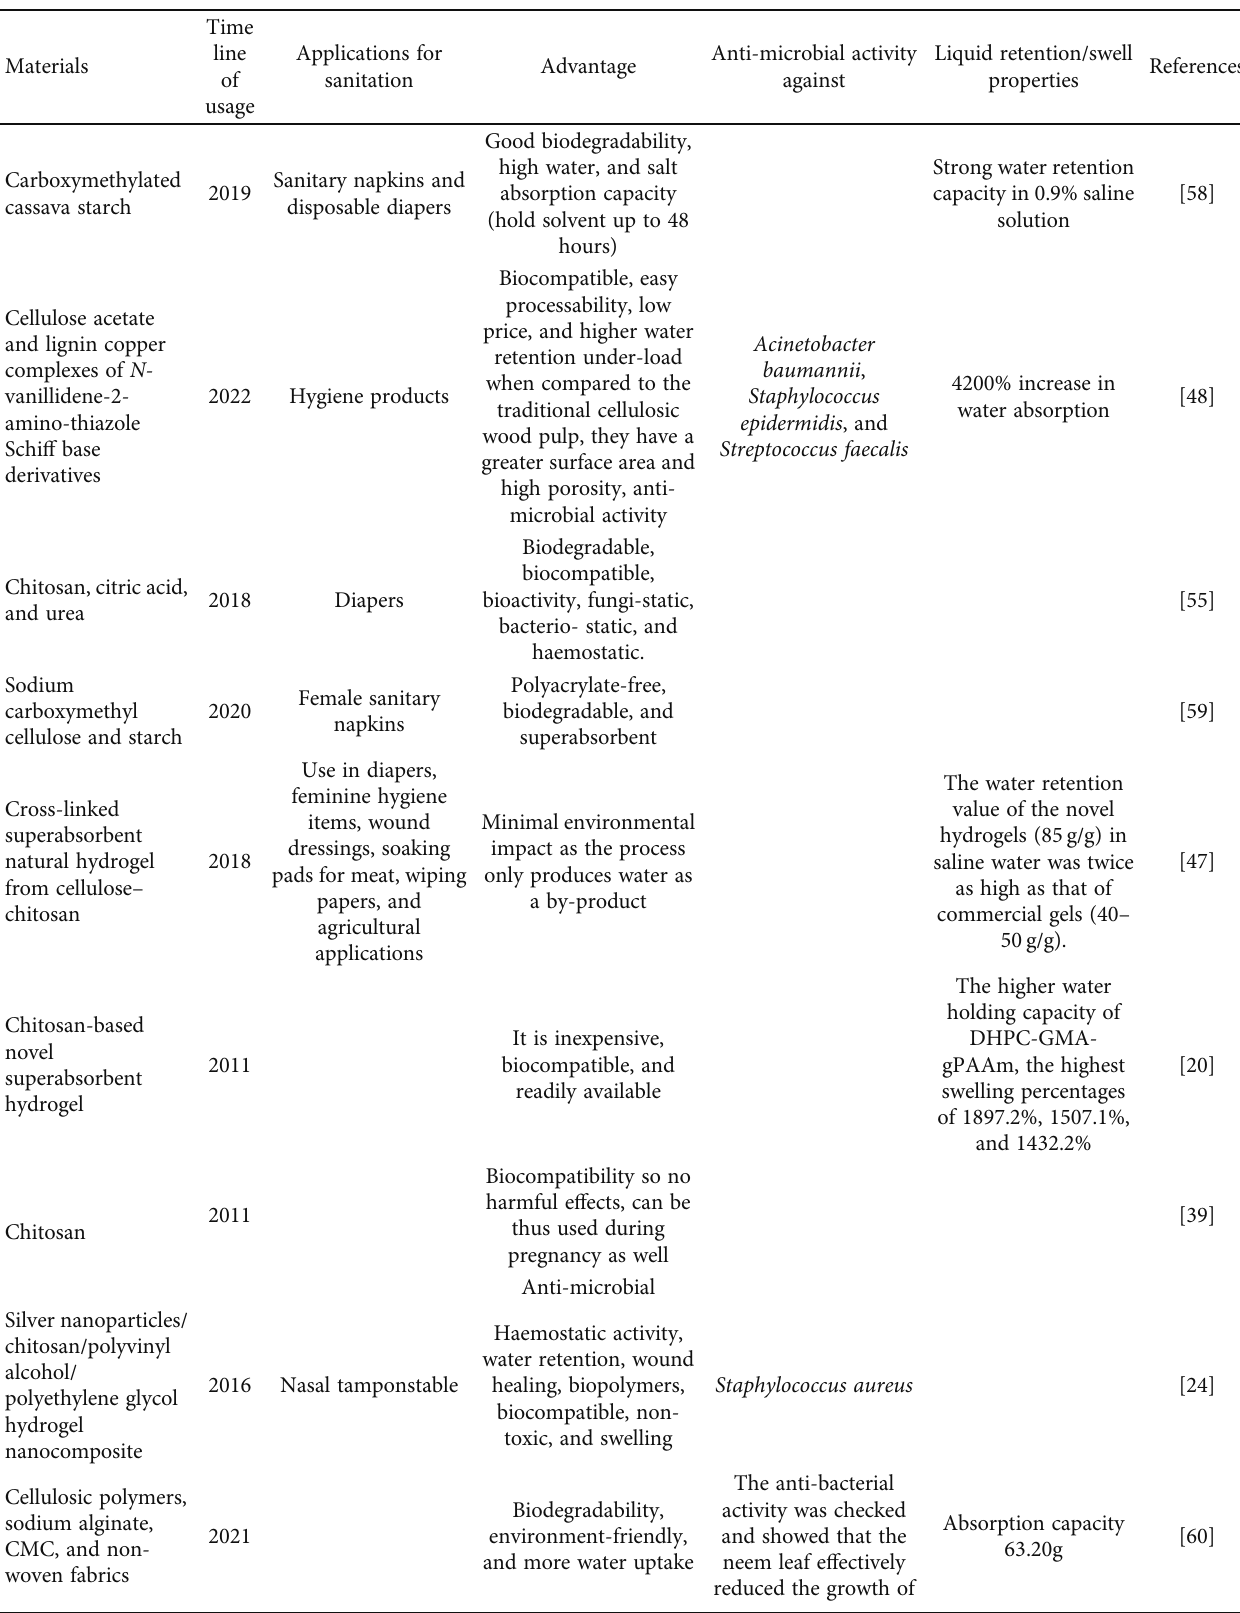
Table 2: Materials that have been used to date for synthesizing sanitary